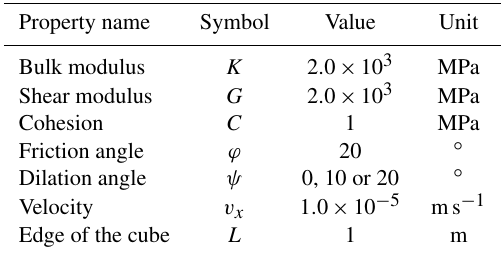
Table 3. Mechanical properties for the oedometer